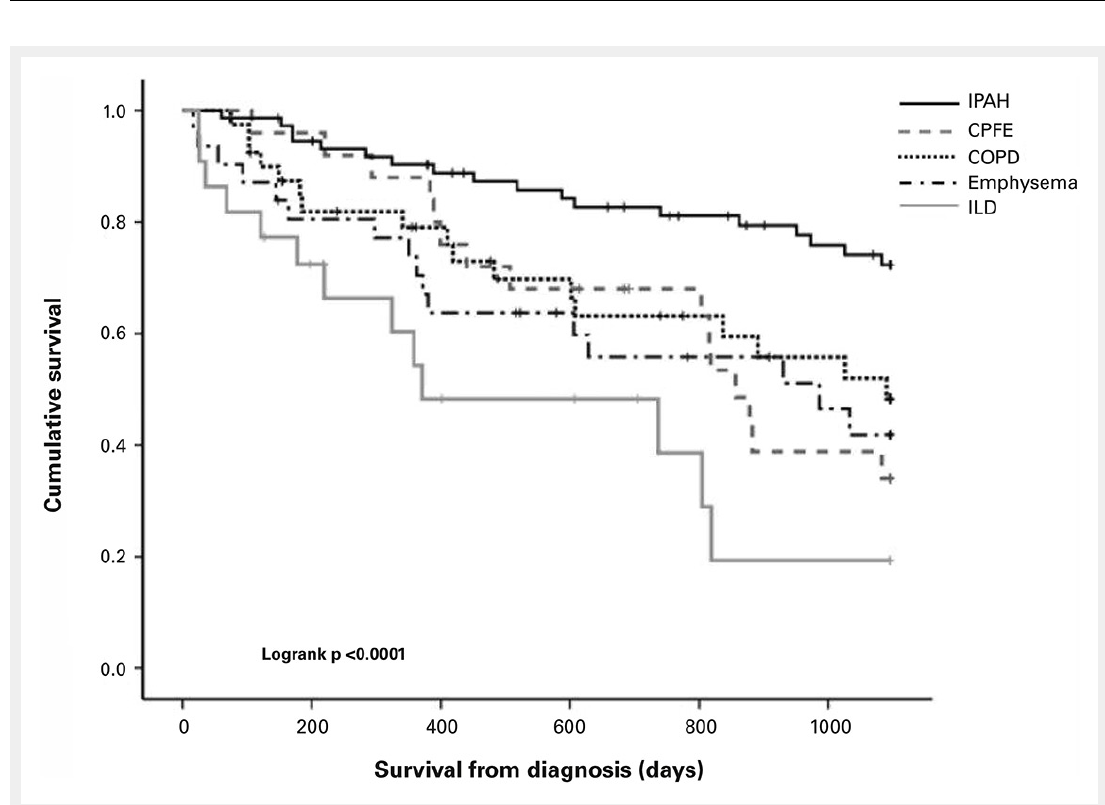
Figure 1 Survival for patients with pulmonary arterial hypertension, pulmonary hypertension associated with CPFE, COPD, emphysema and ILD . Survival for PH-ILD was significantly lower compared with PAH (p <0.0001), PH-COPD (p = 0.0026) and PH-CPFE (p = 0.05), while survival for other lung phenotypes did not differ significantly. CPFE = combined pulmonary fibrosis and emphysema; COPD = chronic obstructive pulmonary disease; ILD = interstitial lung disease; PAH = pulmonary arterial hypertension; PH = pulmonary hypertension, (Reproduced with permission of the European Respiratory Society © Eur Respir J. 2015;46(5):1378–89; DOI: 10.1183/13993003.02307-2014).